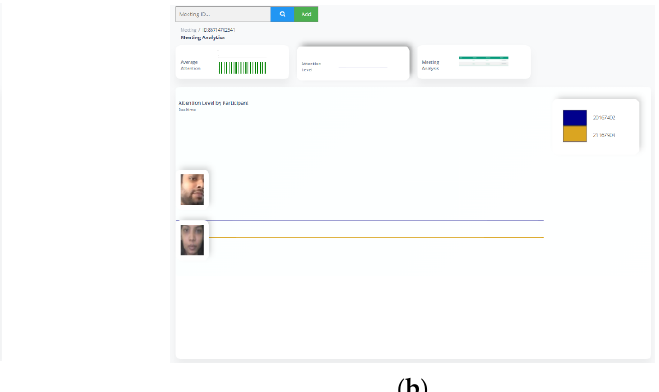
Figure 7. Dashboard views: ( a ) average attention by emotion view; ( b ) attention level by participant view.